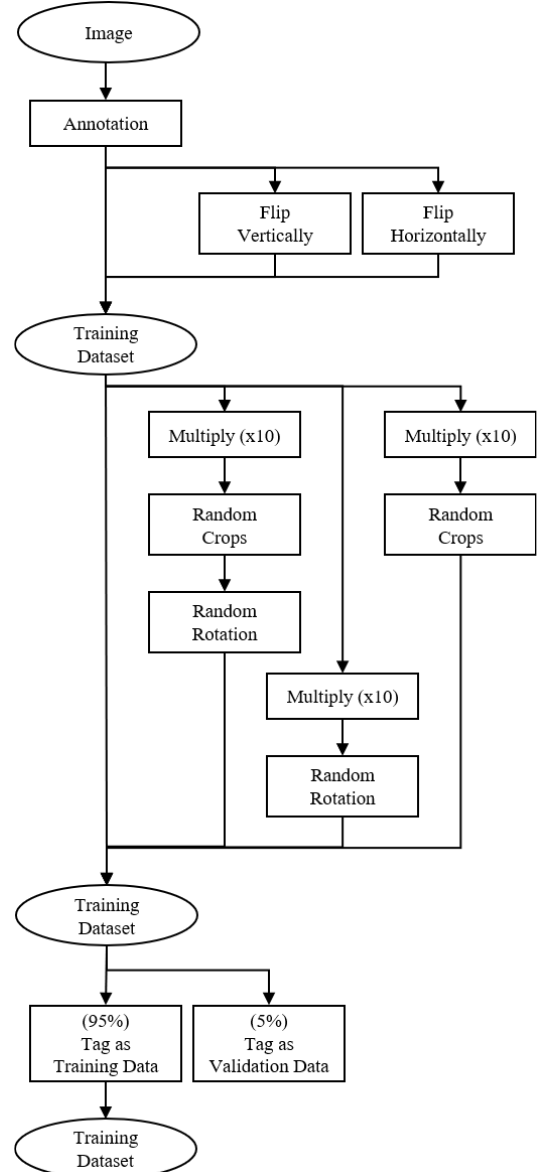
Figure 8. Workflow for creating the training